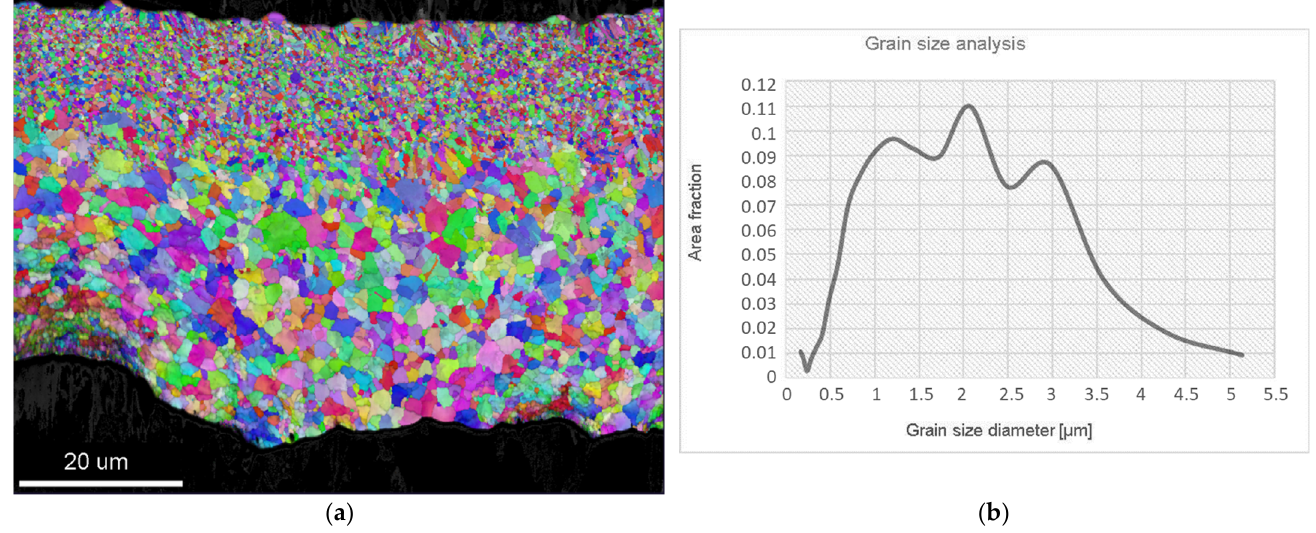
Figure 2. Grain size analysis in a transverse cross-section of the rapidly solidified ribbons: ( a ) EBSD mapping; ( b ) graph of grain diameter vs. area fraction.